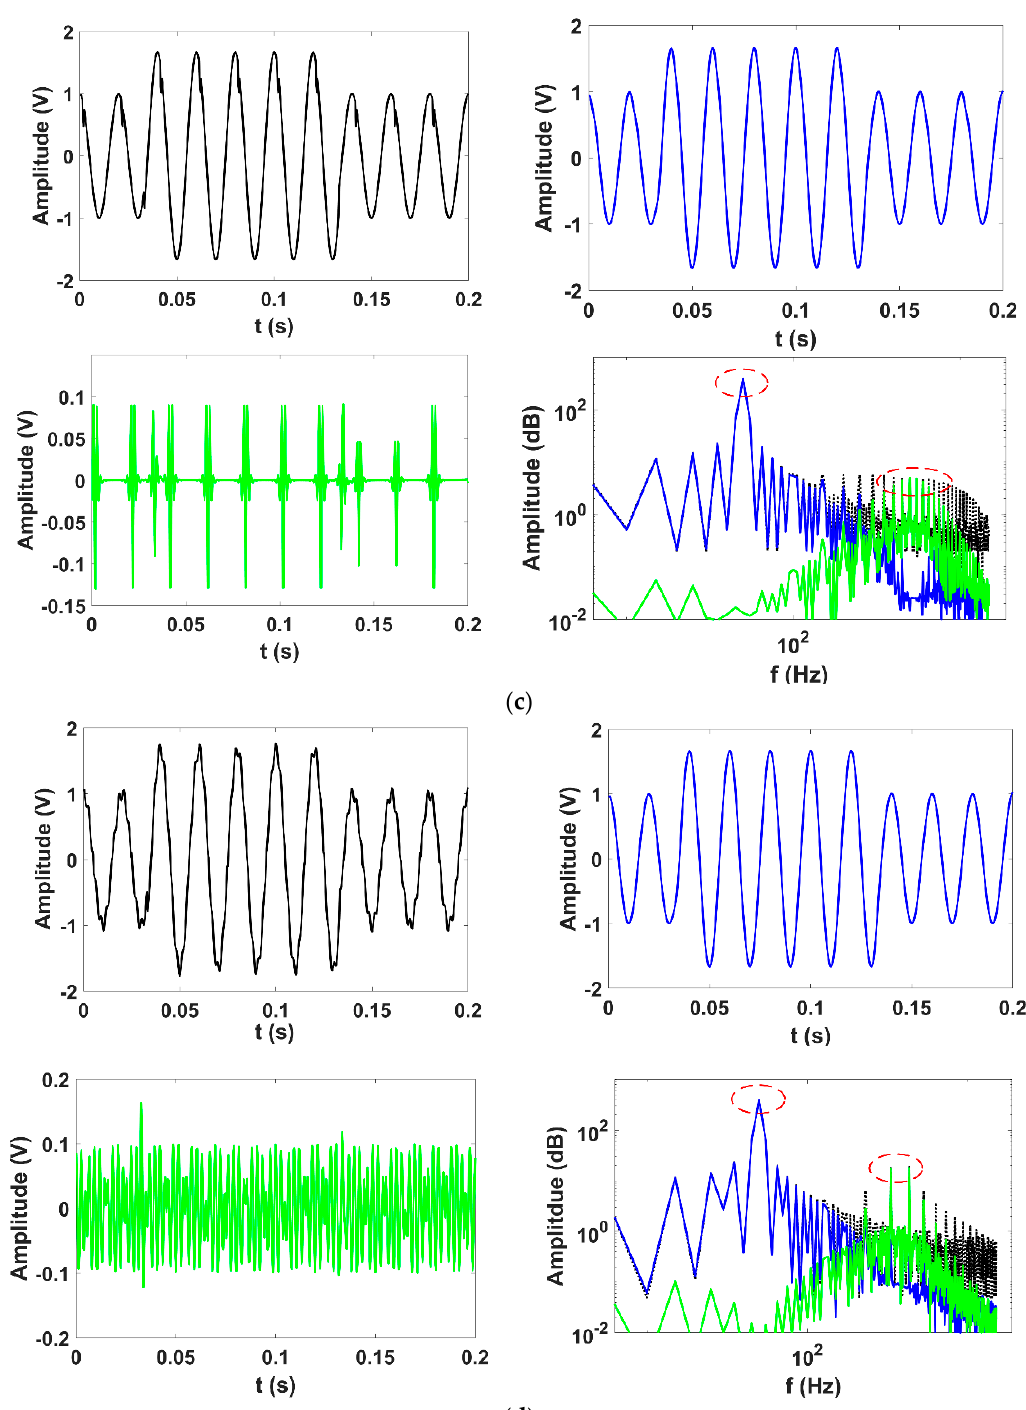
Figure 8. The decomposed voltage results using VMD: ( a ) interruption with oscillation, ( b ) sag with harmonics, ( c ) swell and notch, and ( d ) swell with spike.